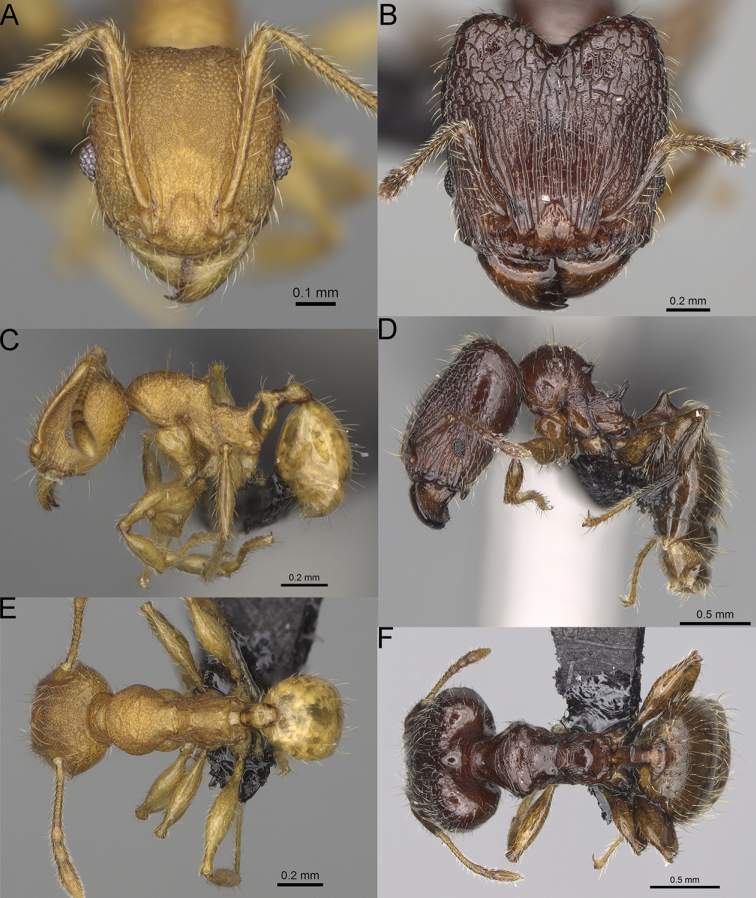
Pheidole
annemariae Forel, full-face view (A), profile (C), and dorsal view (E) of minor worker (CASENT0077287) and full-face view (B), profile (D), and dorsal view (F) of major worker (CASENT0077290).